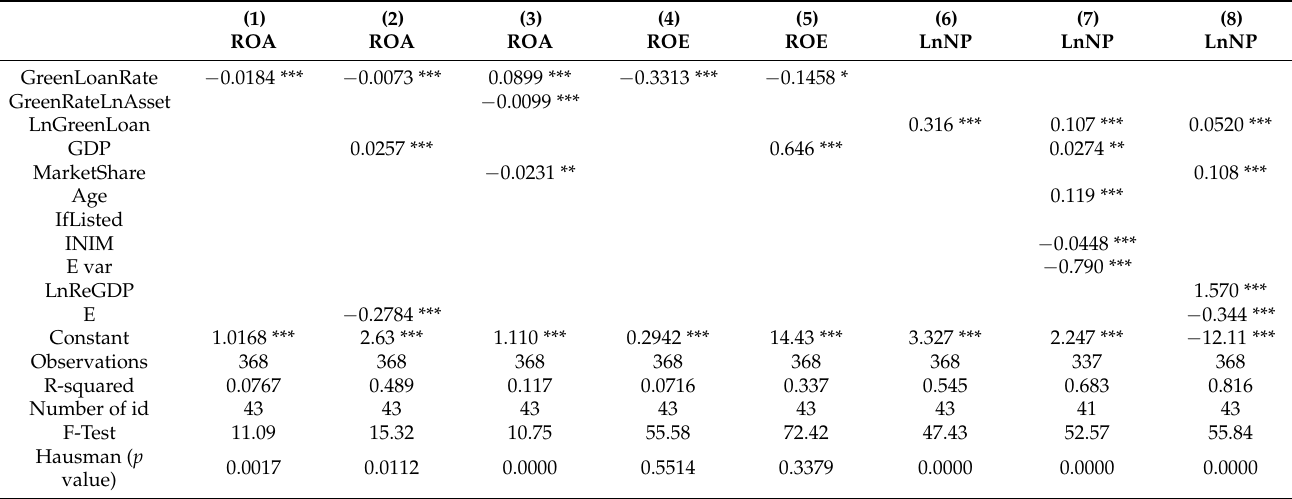
Table 2. Regression results for the different types of index